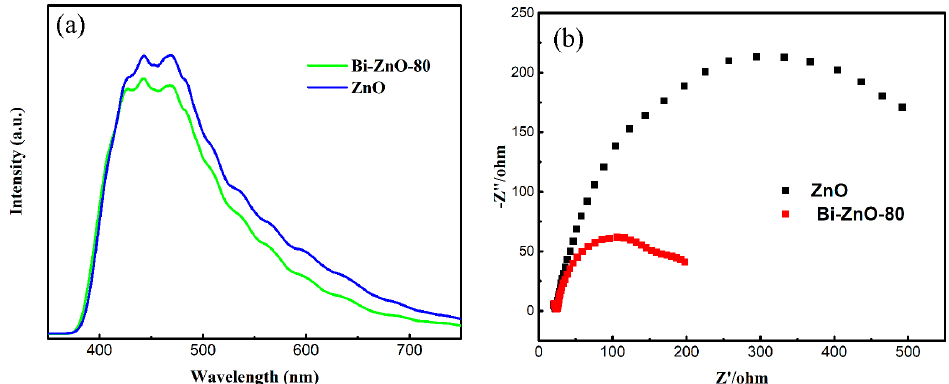
Figure 6. ( a ) PL spectra of ZnO and Bi-ZnO-80 photocatalysts and ( b ) EIS plots of the ZnO and Bi-ZnO-80 photocatalysts with light on/off cycles under the irradiation of visible light ( λ > 420 nm) [Na 2 SO 4 = 0.1 M].